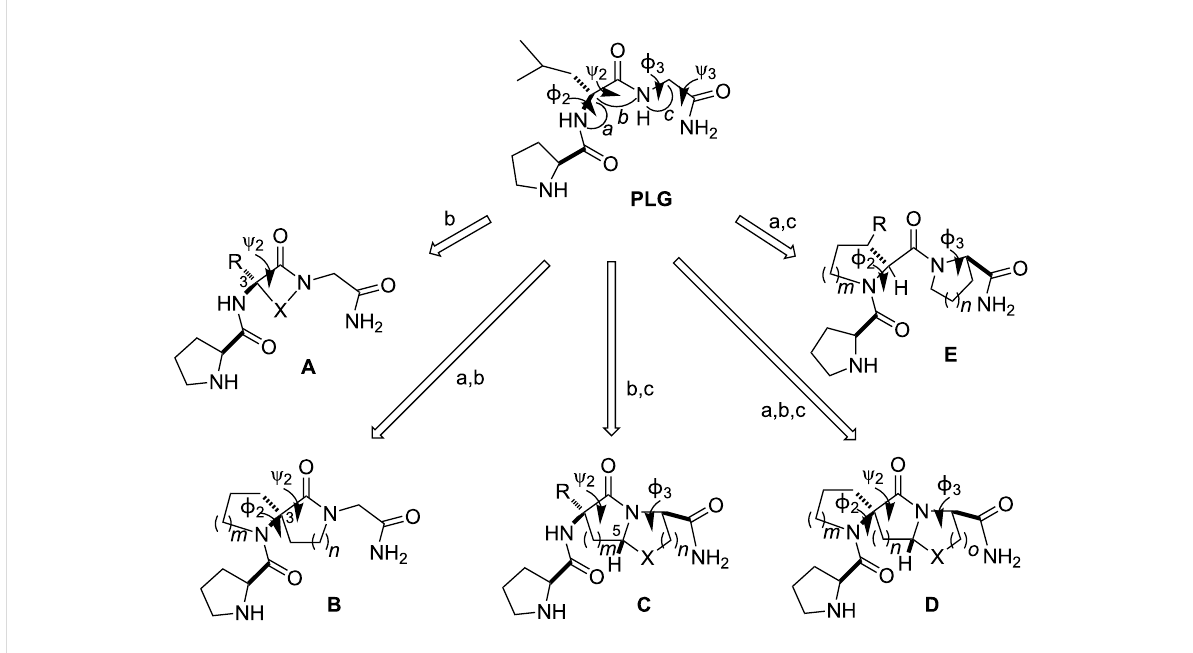
Figure 1: PLG peptidomimetic design approach. The Φ 2 , ψ 2 , Φ 3 , and ψ 3 torsion angles define the postulated β -turn structure of PLG and a–c repre- sent bridging connections made between the designated atoms of the peptide backbone to generate the peptidomimetic analogues A – E of PLG.